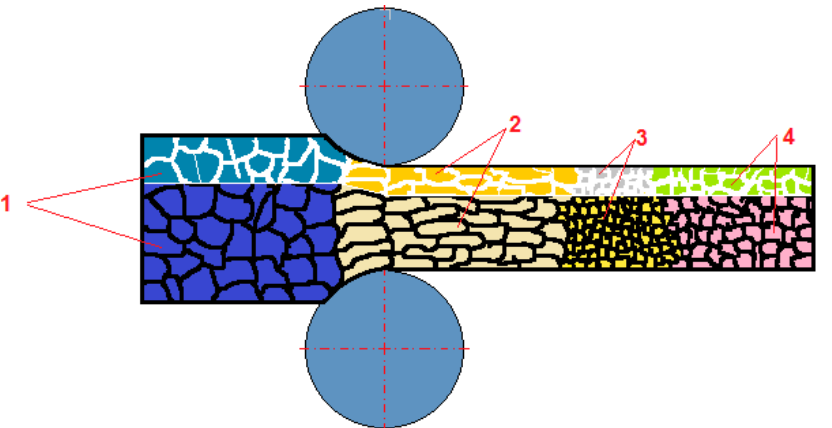
Figure 1. Scheme of grain size changes occurring in the structures of plastically deformed metals during hot rolling; 1, bimetal layers; 2, static recovery; 3, static recrystallization; 4, grain growth (based on [7,12–14,19,23]).